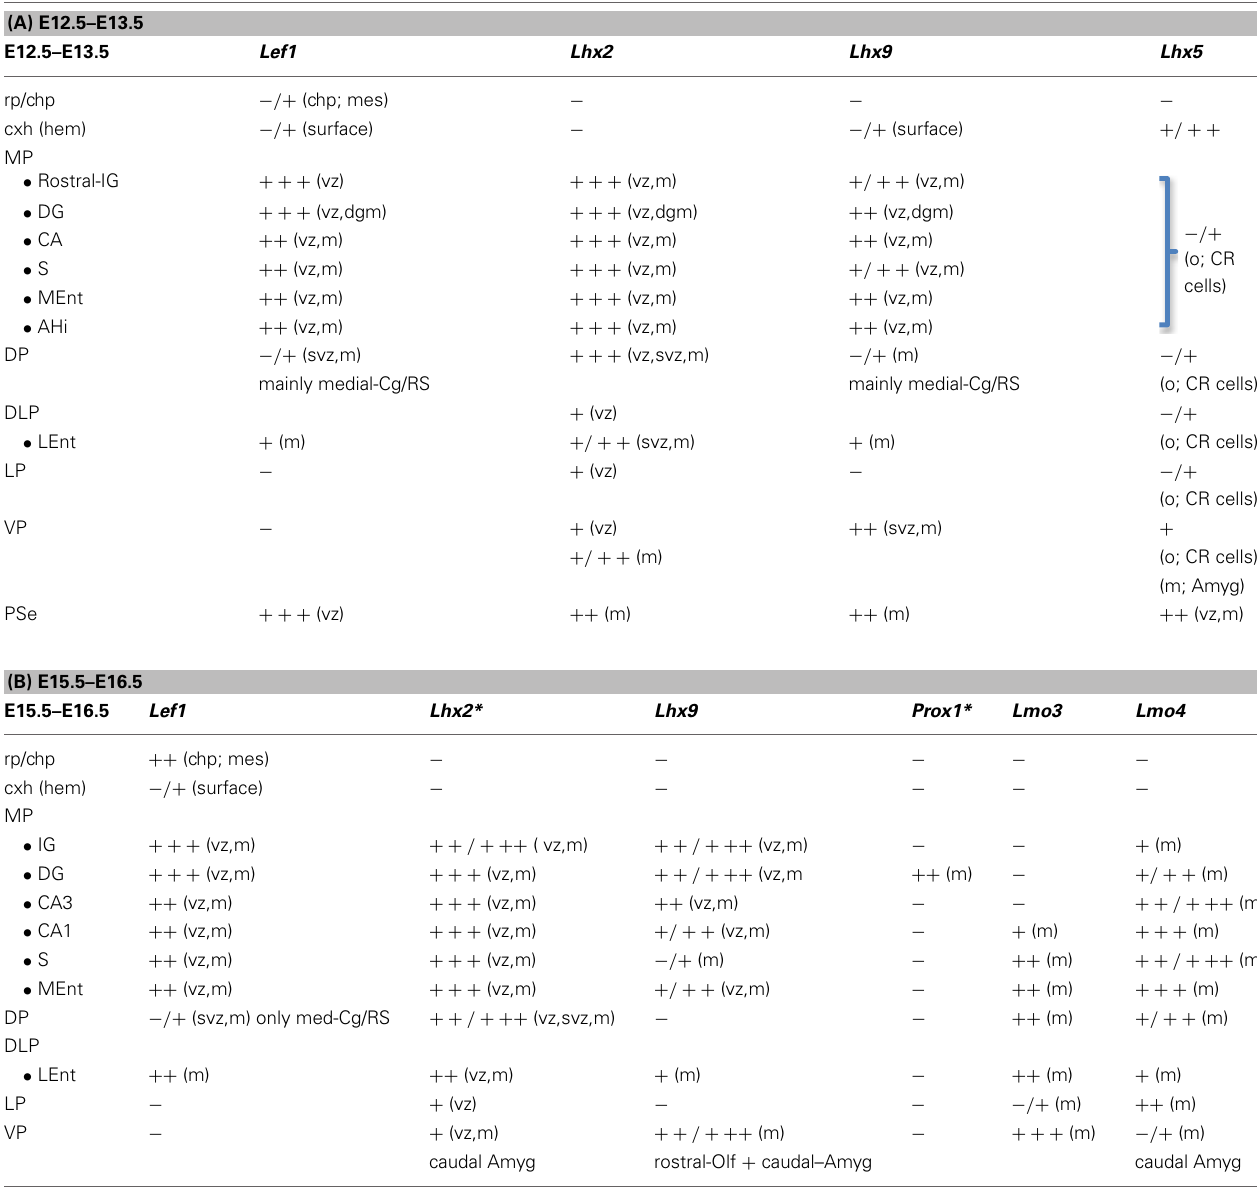
Table 1 | Combinatorial expression of Lef1 and other regulatory genes in the pallial progenitor zones and hippocampal complex primordia of developing